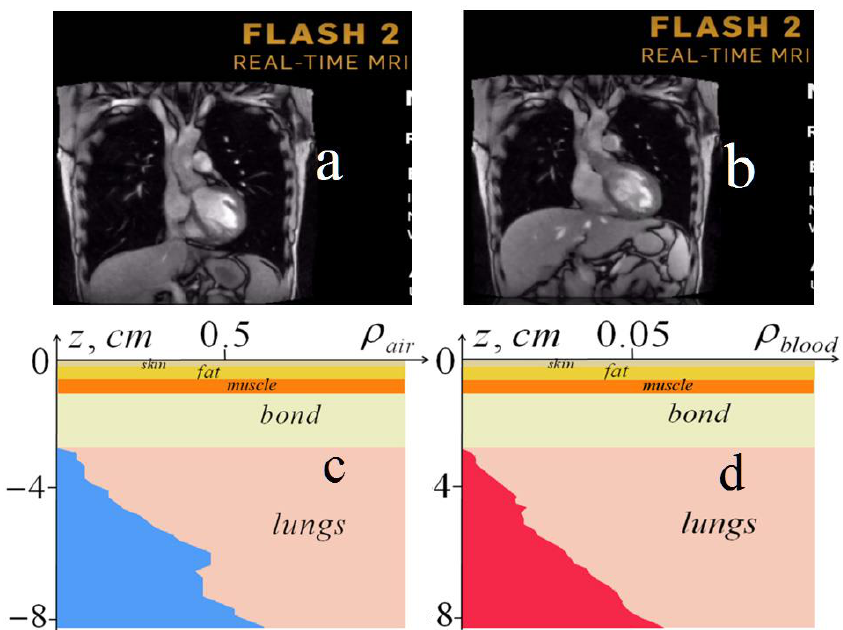
Figure 11. Upper row: screenshots of the thorax cross-sections from the MRI animation: ( a ) in phases of inhalation and systole; ( b ) in phases of exhalation and diastole. Bottom row: screenshots of the developed microwave dynamical tomography: ( c ) depth profile of the relative air content in the phase of inhalation; ( d ) depth profile of the relative blood content in the phase of systole. As is easily seen in the MRI images (Figure 11a,b), the only visible objects in lungs